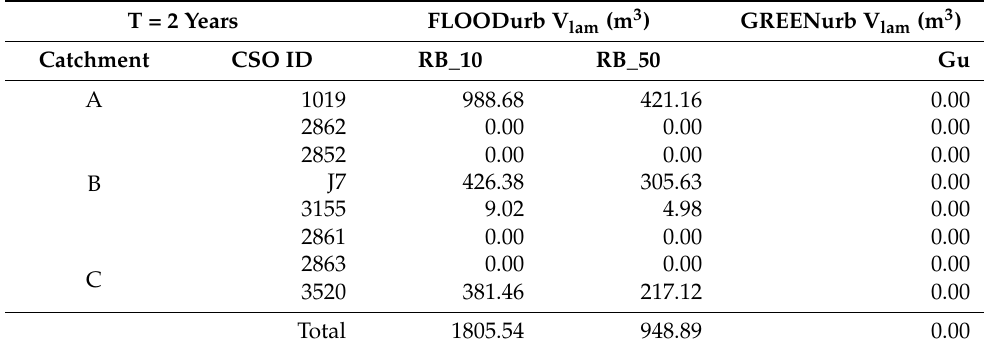
Table 5. Stormwater detention tanks volumes in the hybrid scenario for a 2-year return-period rainfall.